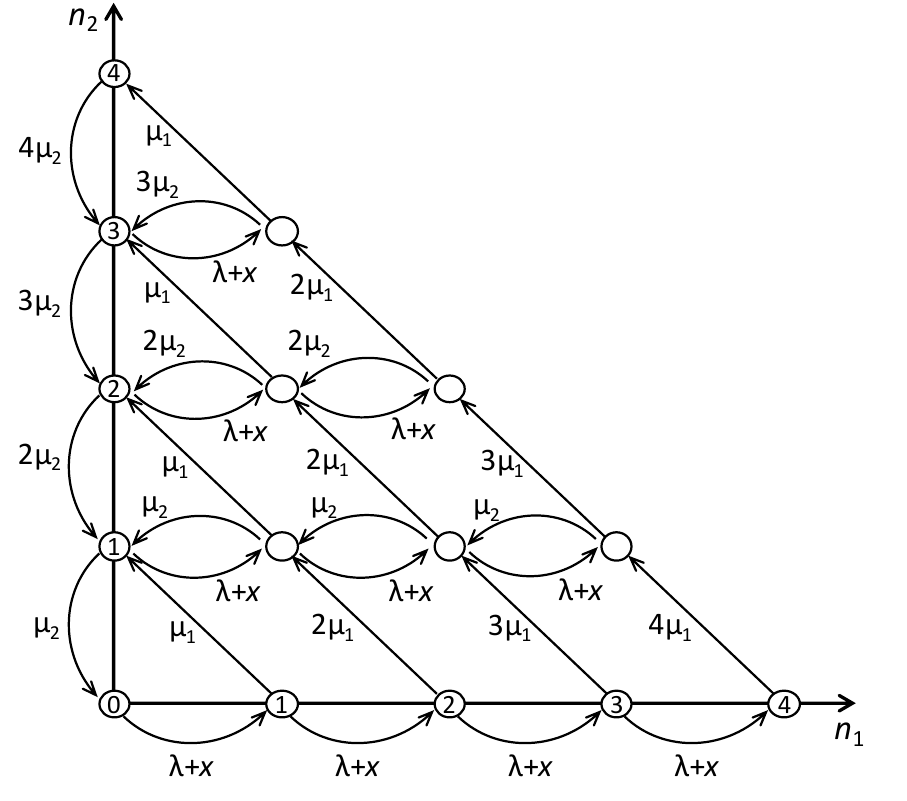
Figure 1. Transition for states ( n 1 , n 2 )